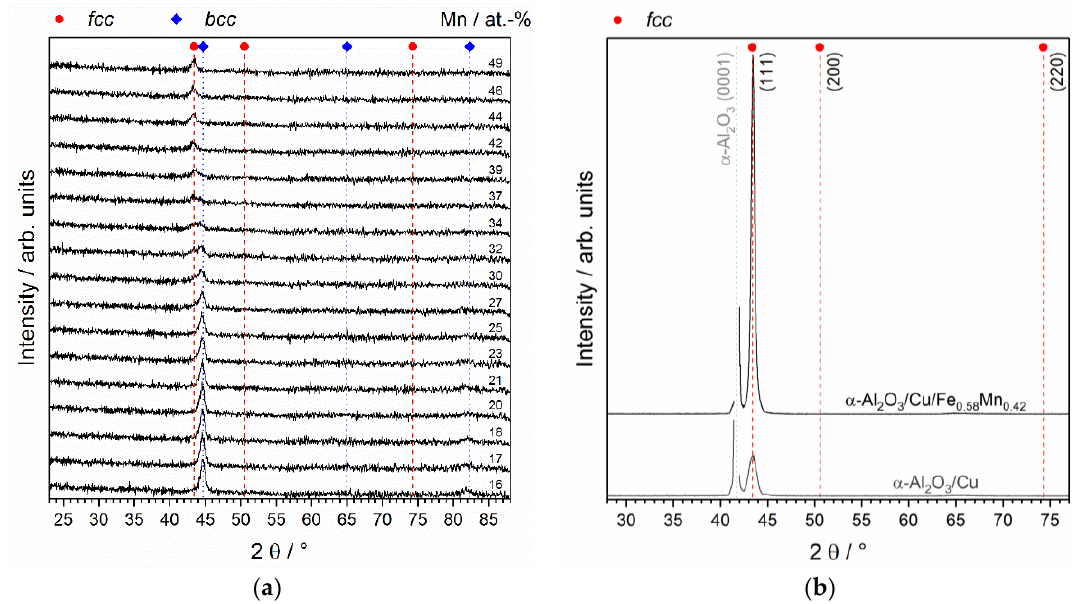
Figure 2. ( a ) X-ray diffraction (XRD) scans (2θ-scans at fixed incidence angle ω) of α-Al 2 O 3 /Cu/FeMn in dependence of the Mn content of the FeMn layer; ( b ) XRD scan (Bragg-Brentano) of α-Al 2 O 3 /Cu/Fe 0.58 Mn 0.42 , which is chosen for transmission electron microscopy (TEM) analysis (comparison: α-Al 2 O 3 /Cu without FeMn layer).